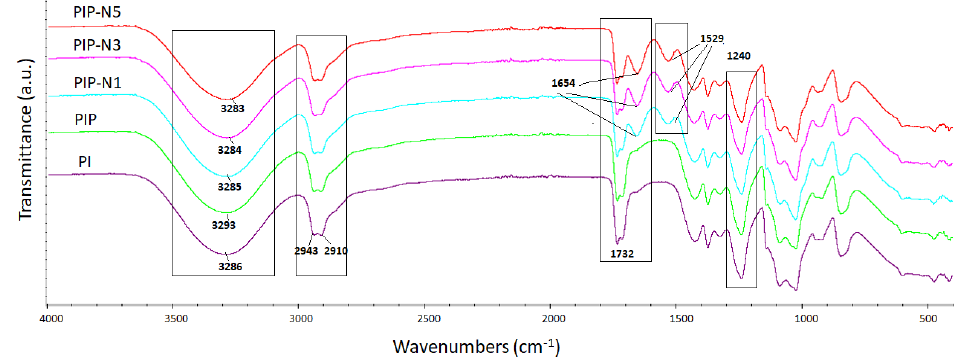
Figure 5. FT-IR spectra of the neat polymer films and sustainable Pickering films.